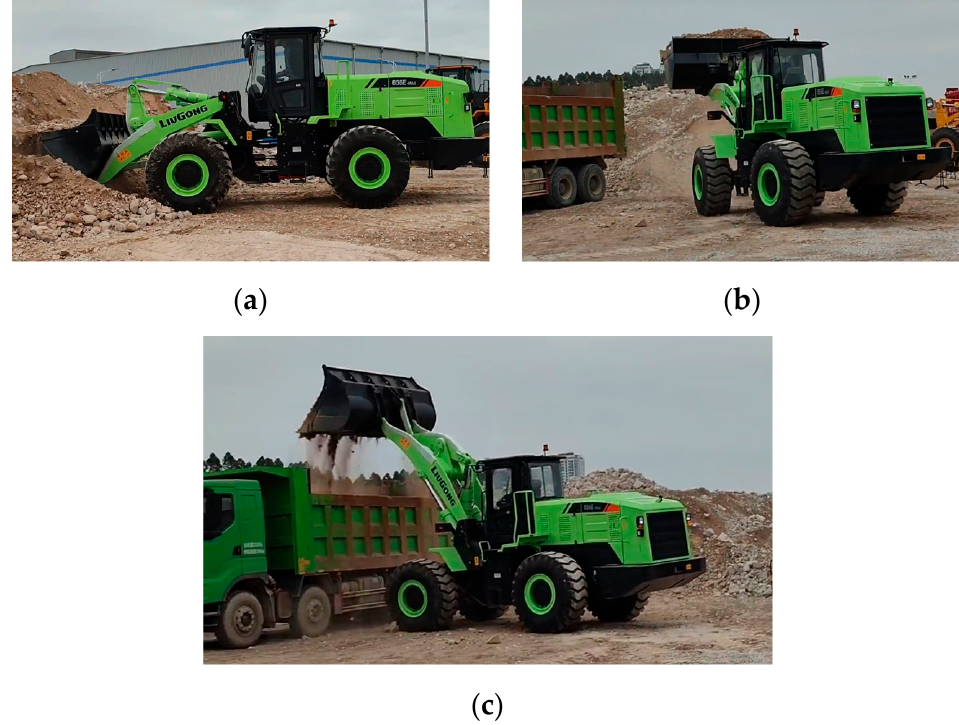
Figure 1. Photographs of a loader working. ( a ) Loading. ( b ) Transportation. ( c ) Unloading.